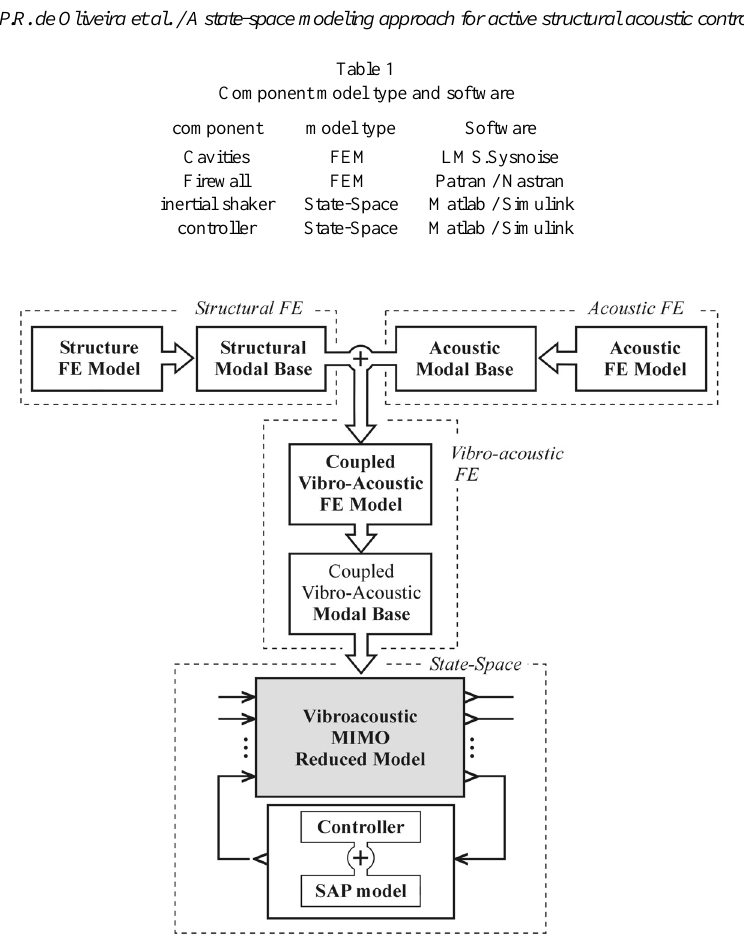
Fig. 2. Modeling procedure